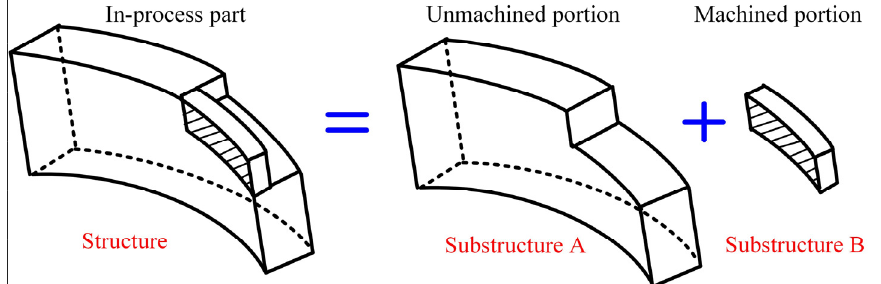
Figure 1. Decomposition of in-process part.